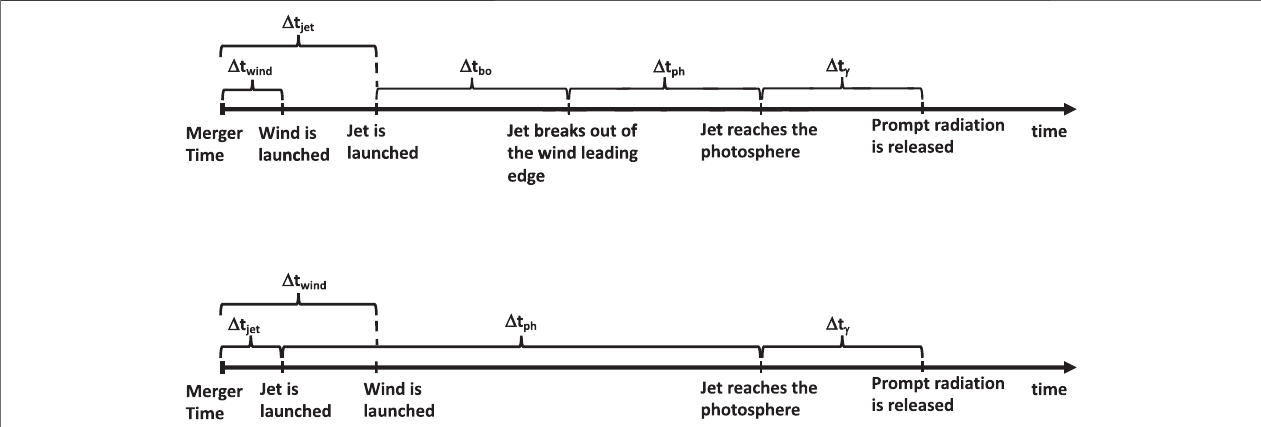
FIGURE 1 | The two possible timelines with all the phases that may contribute to the detected delay Δ t GW − c . Due to the presence of a structured out fl ow, GW170817 most likely followed the top timeline. The relative contribution ofthe various phases is a matter of debate, but consensus is growing around Δ t wind < Δ t jet ≪